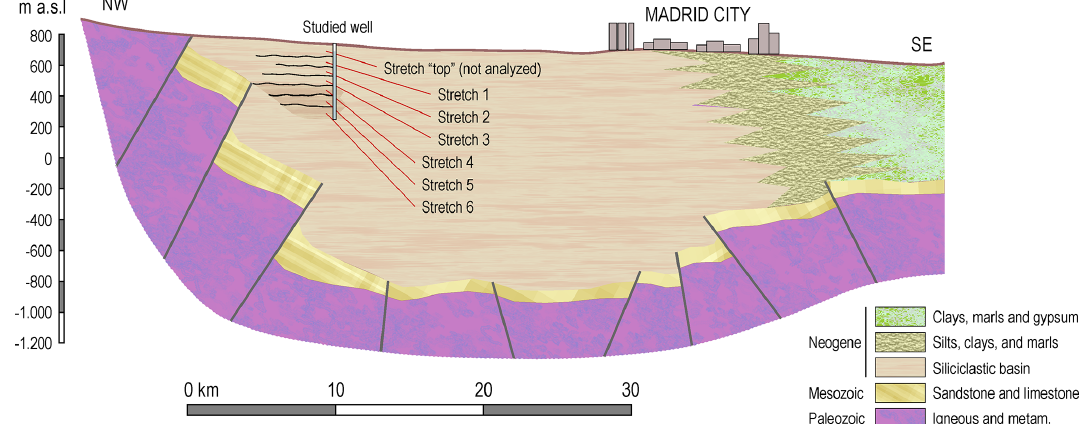
Figure 11. Schematic geologic section of the Madrid basin (adapted from Llamas, 1976, and Navarro et al., 1993) with stretches established in the studied